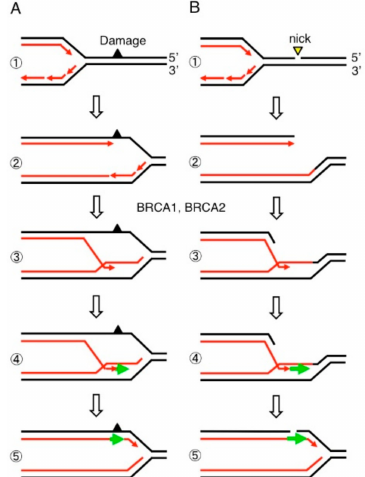
Figure 1. Release of replication blockage by breast cancer susceptibility gene 1 (BRCA1) and breast cancer susceptibility gene 2 (BRCA2). DNA replication forks often stall at both damaged nucleotides ( A ) and single-strand breaks ( B ) on template strands (Step 1). Homology-directed repair (HDR) proteins including BRCA1 and BRCA2 initiate strand invasion of the 3 (cid:48) end of nascent DNA strands into the intact sister chromatid (Step 3) followed by DNA synthesis (Step 4, green arrow). This pathway allows the fork to move past the damaged nucleotides ( A ) and single-strand breaks ( B ) (Step 5). 2. The Consequences of Failure of Catalysis by DNA Topoisomerase I and